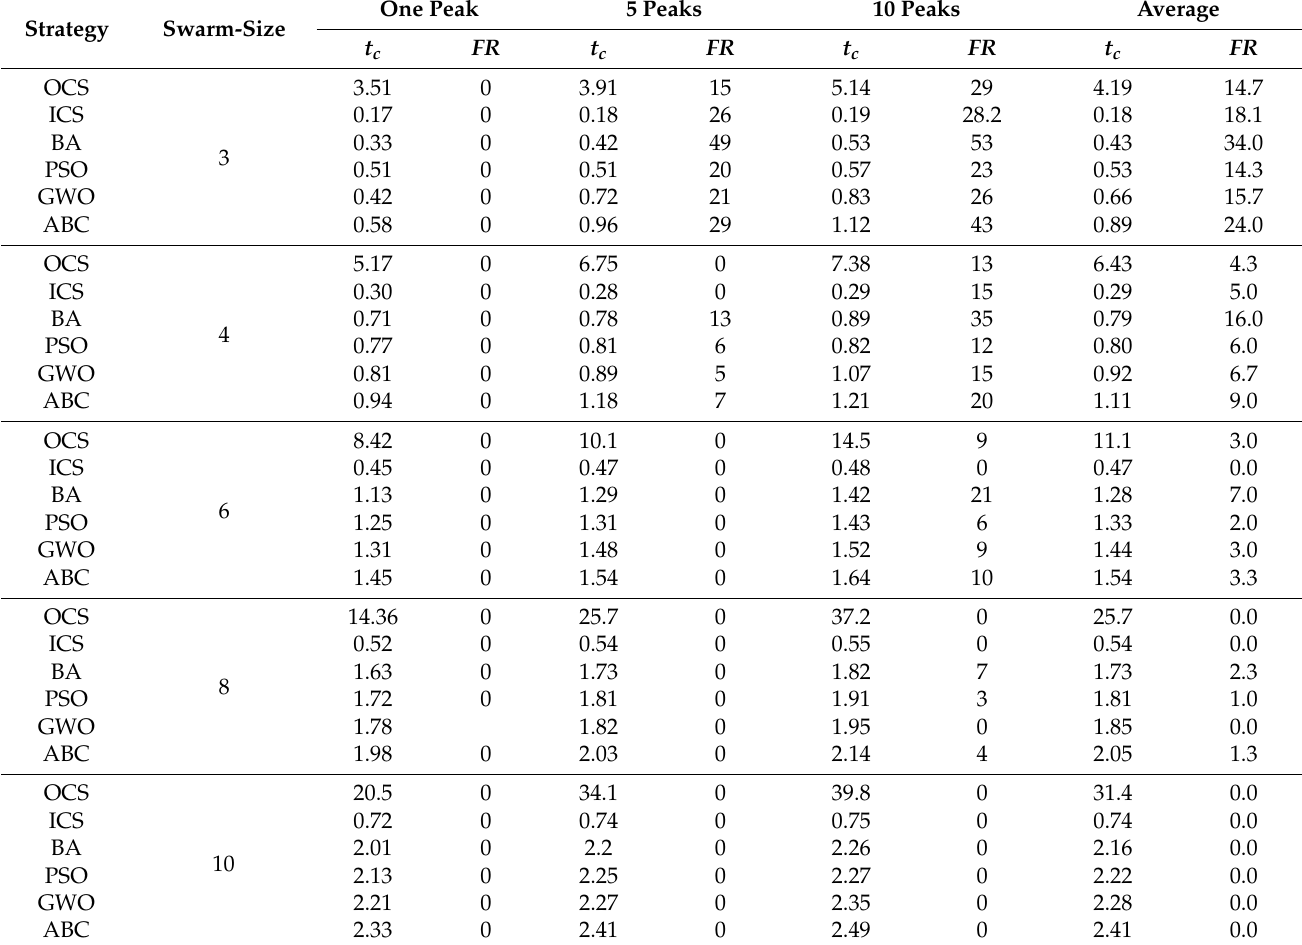
Table 2. Simulation results for all SOT under review with varying swarm-size and number of